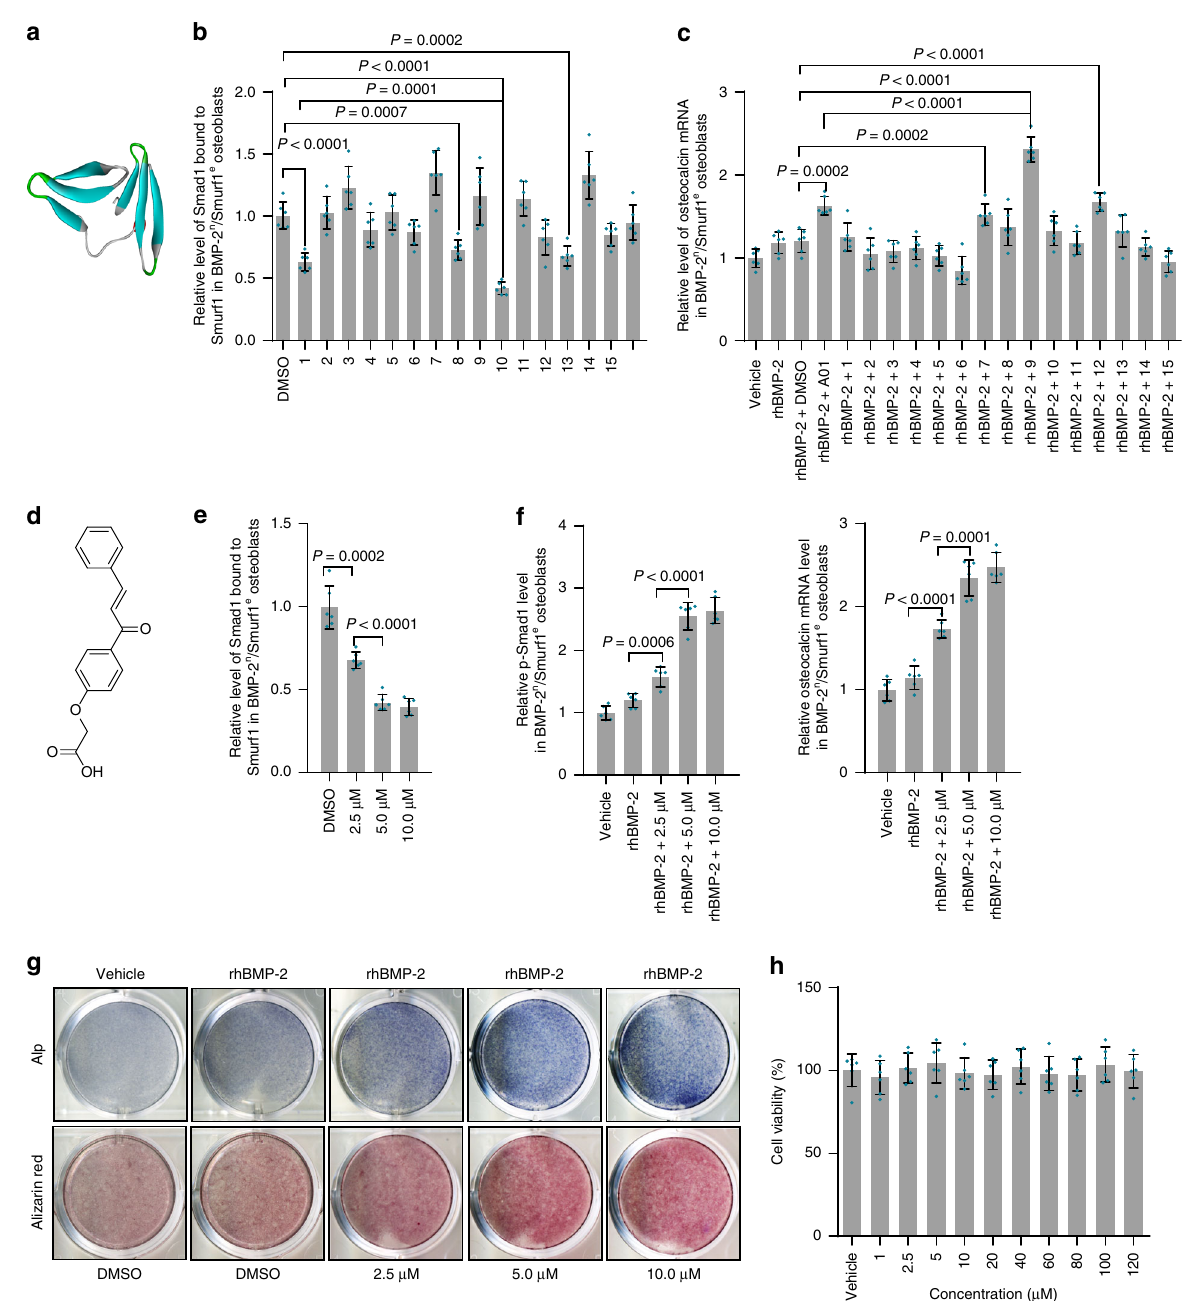
Fig. 4 Virtual screening of Smurf1 small molecular inhibitors and in vitro effects of the inhibitors. a Homology modeling of Smurf1 WW1-WW2 domains. Left beta sheet, WW1 domain; right beta sheet, WW2 domain. b Effects of the top-ranked 15 small molecules (5.0 μ M) on Smurf1 activity (Smad1 bound to Smurf1) in osteoblasts from BMP-2 n /Smurf1 e subgroup of 15-month-old osteoporotic mice (OVX at 6 months old). A01, a previously reported Smurf1 inhibitor. c Effects of the 15 small molecules (5.0 μ M) on osteocalcin mRNA expression in the above osteoblasts with presence of 100 ng ml – 1 rhBMP-2